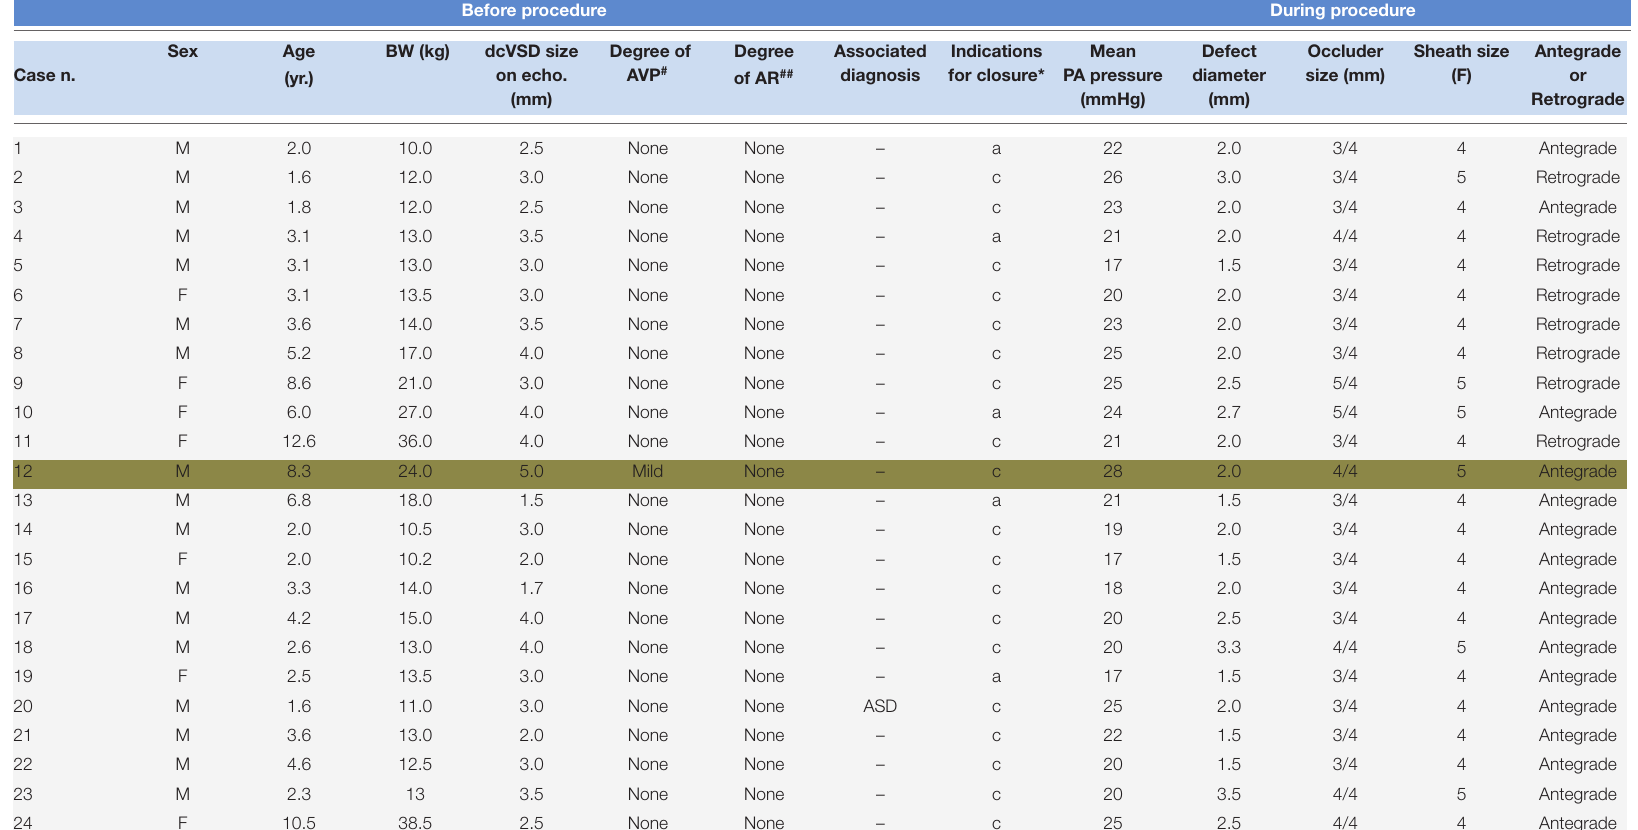
TABLE 1 | The clinical characteristics of 24 patients with dcVSD. Before procedure During procedure